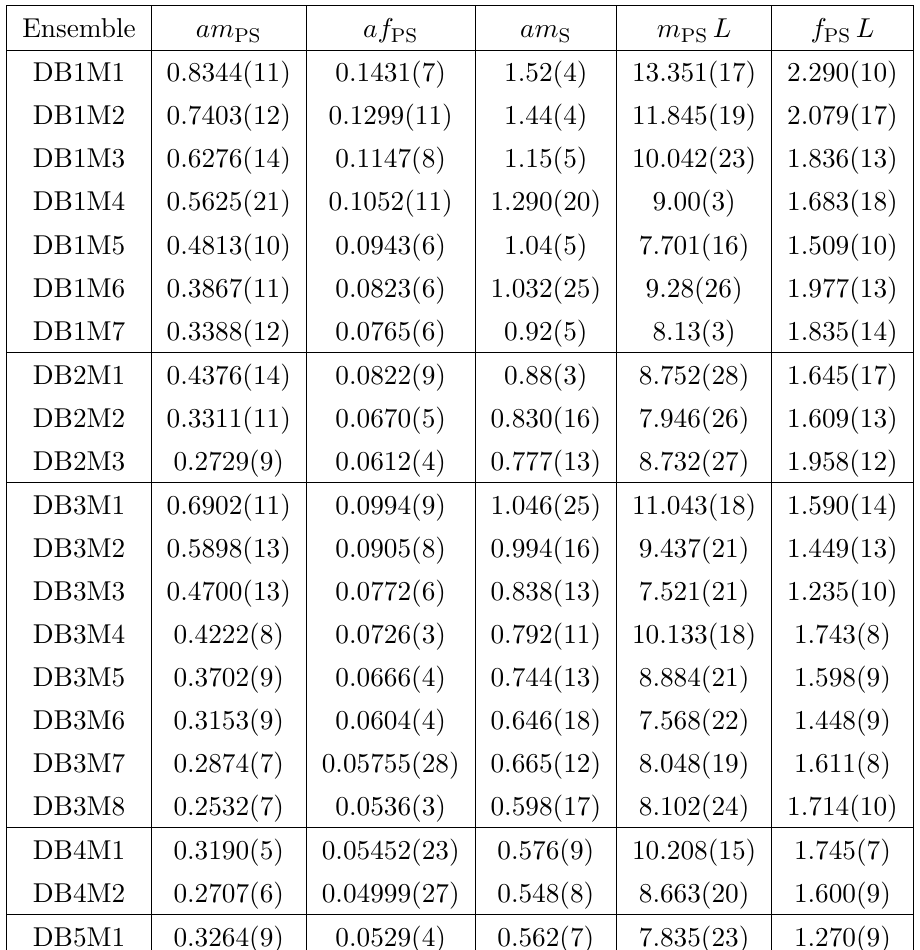
Table 6. Masses and (renormalised) decay constants for (cid:13)avoured mesons sourced by pseudoscalar (PS) and scalar (S) operators in units of the lattice spacing a . The pseudoscalar decay constant f PS is renormalised via the one-loop perturbative matching in eq. (4.6). Statistical uncertainties are indicated in